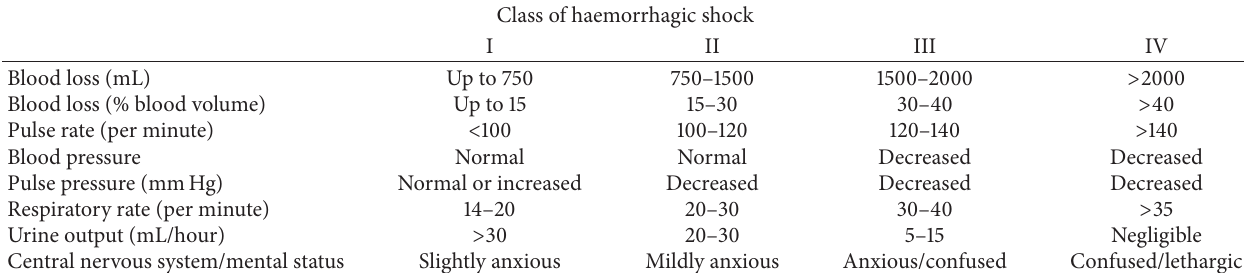
Table 1: Classification of haemorrhagic shock (ATLS manual American College of